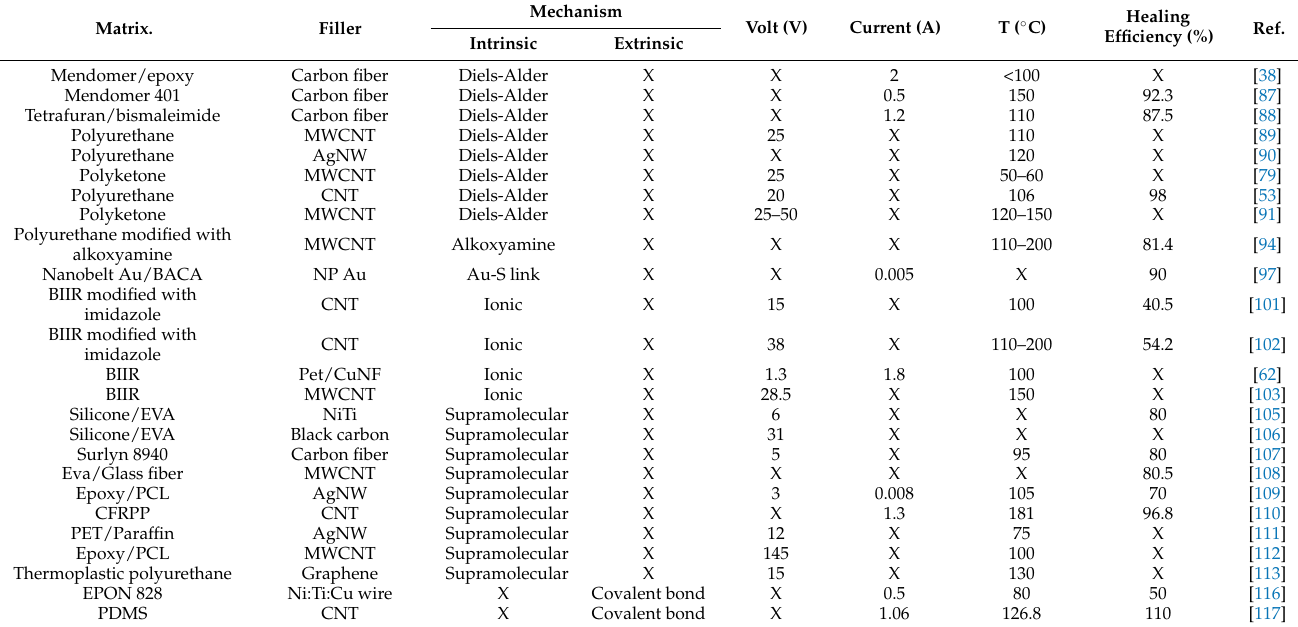
Table 1. Summary of self-healing materials by Joule